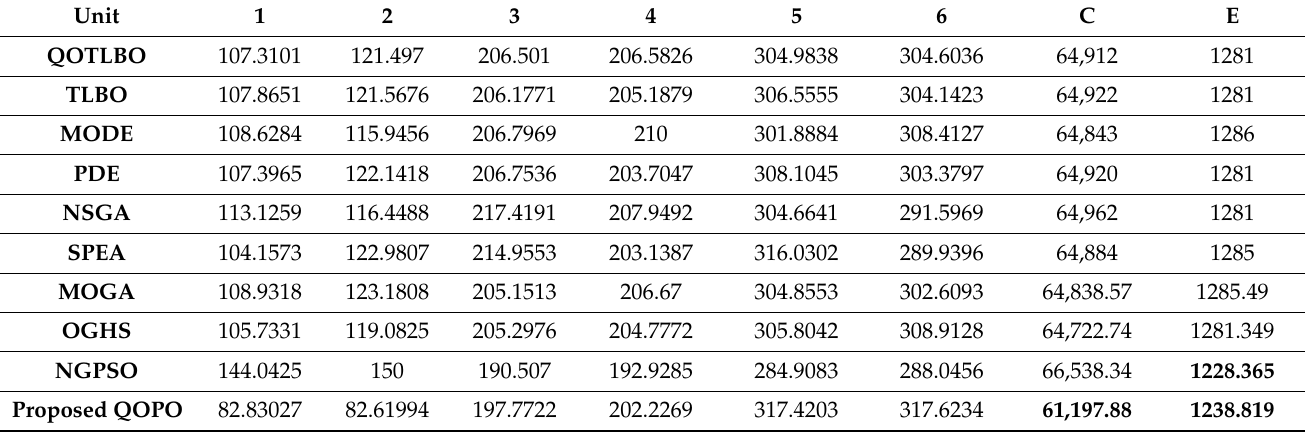
Table 10. Comparison of results of six-unit system for the load demand of 1200